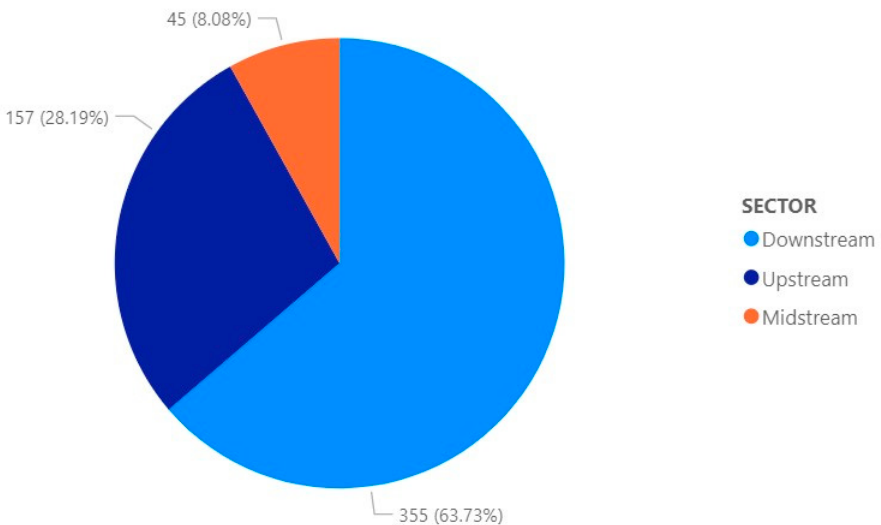
Figure 8. Contribution of scientific publications by sector.